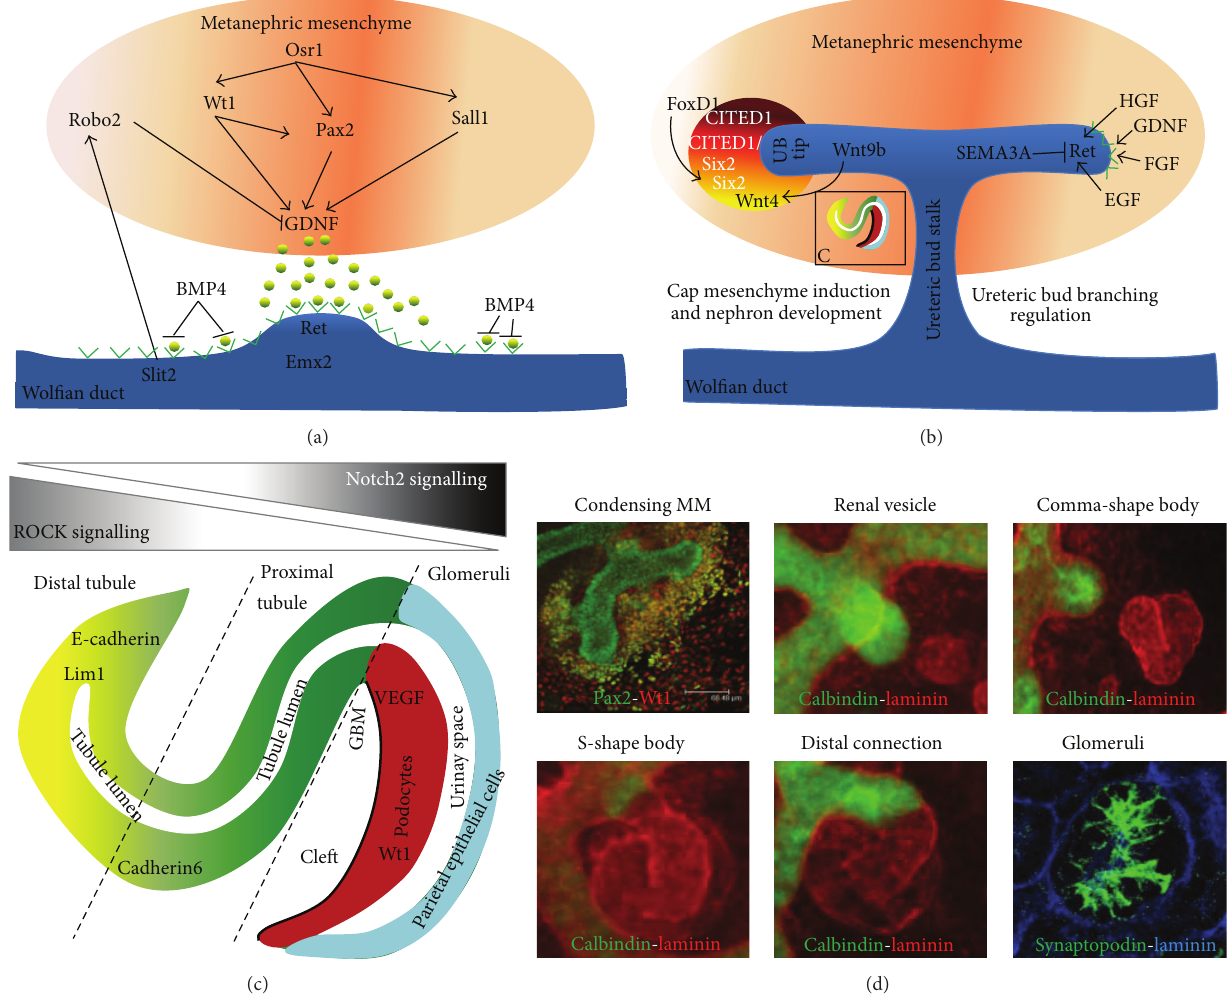
Figure 3: Schematic of kidney development: (a) MM influence UB outgrowth from the Wolffian duct. Genes, such as Osr1, Wt1, Pax2, and Sall1, upregulate GDNF production. GDNF is secreted from the MM and binds to Ret receptors and induces budding of the ureteric bud. The ectopic bud outgrowth is prevented by the BMP4 that surrounds Wolffian duct. Slit2 and Robo2 action reduce GDNF production in the anterior part on the MM. (b) Once the UB invades the MM, its branching is regulated by HGF, FGF, GDNF, and EGF inductive action on Ret, while Semaphorin 3A is downregulating the UB branching (left side). At the tip of the UB, the MM condenses and forms heterogenic cell population with expression of CITED1, Six2, and Wnt4. Upon Wnt9b action, Wnt4 induced nephron formation by comma- and S- shape body formation. MET takes place. (c) Distal nephron development depends on ROCK signalling, while proximal nephron—glomeruli development depends on Notch2 signalling. (d) Microphotographs of kidney rudiments developing in vitro , presenting all main stages of nephron